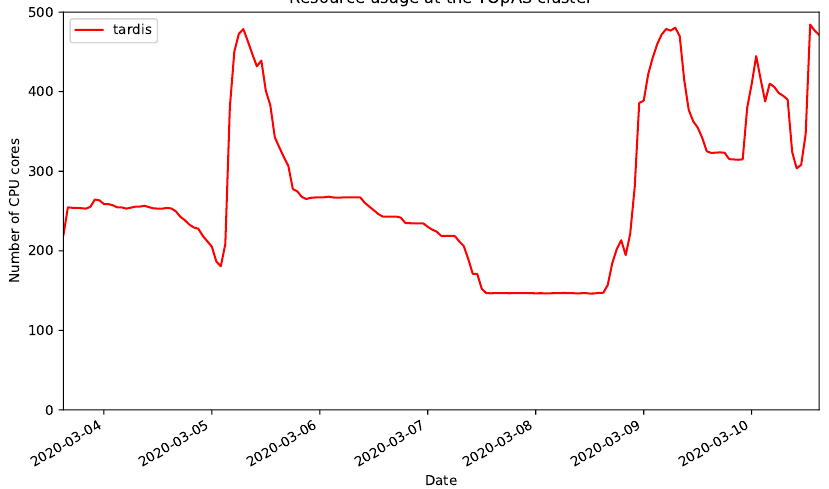
Figure 4. Utilization of the TOpAS cluster for WLCG workloads submitted by the CMS and Belle II collaborations in a seven-day period. The workloads are run when the cluster is not fully utilized by end-user analysis